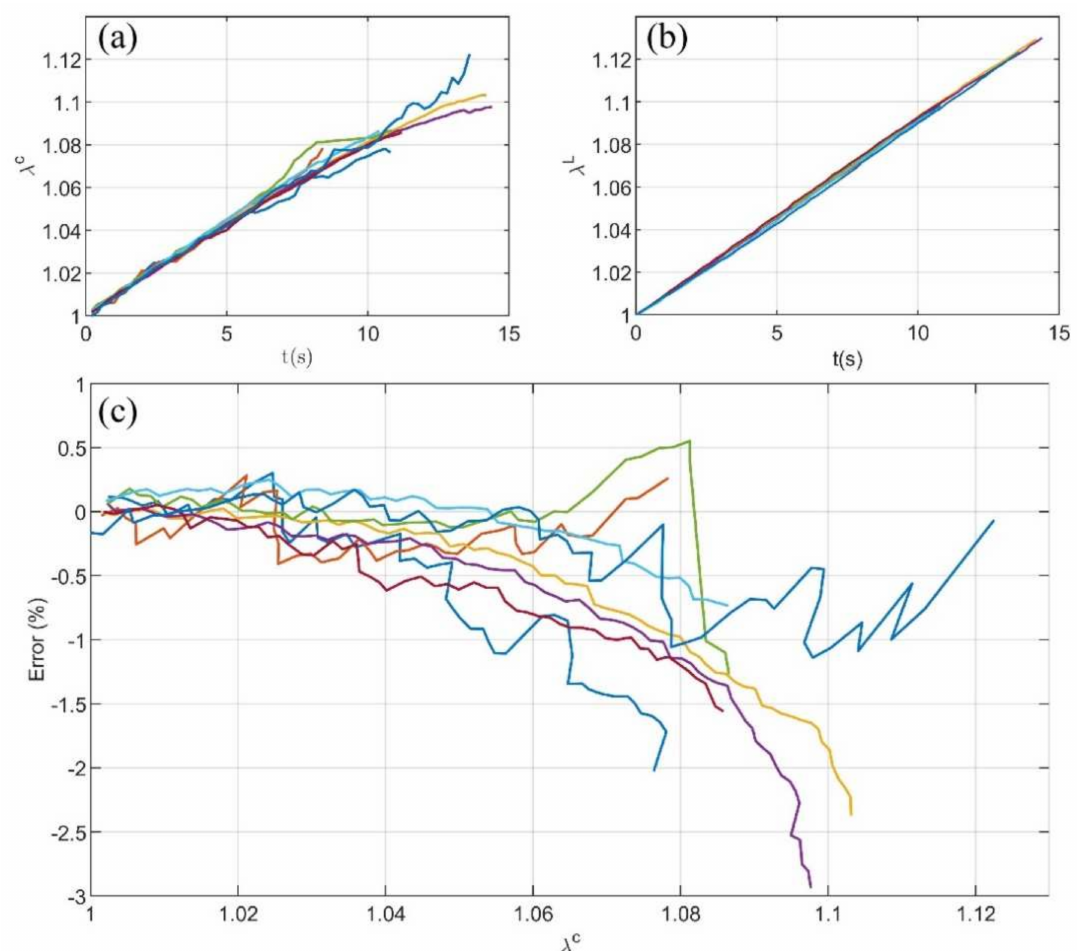
Figure A2. Stretch ratio in the loaded-to-failure test: ( a ) results computed from video camera recordings at the central area of the specimen ( λ c ); ( b ) results computed from the LVDT recordings between gripping points of the specimen ( λ L ); and ( c ) percentage error of λ L with respect to λ c